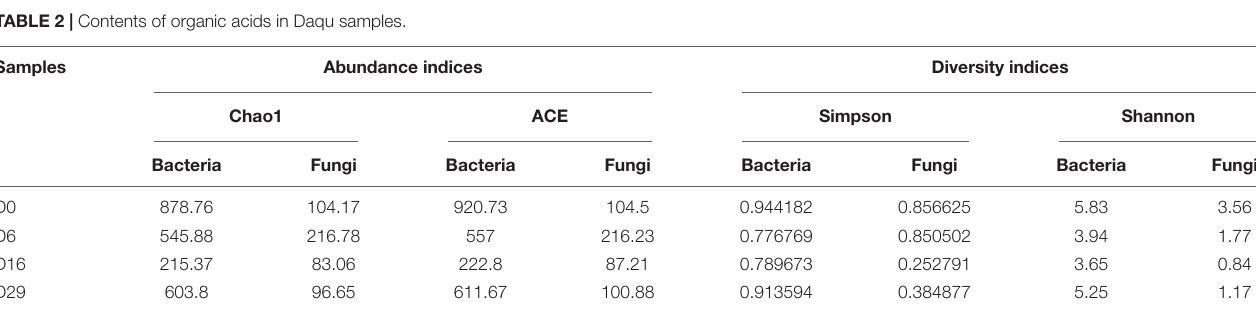
TABLE 2 | Contents of organic acids in Daqu